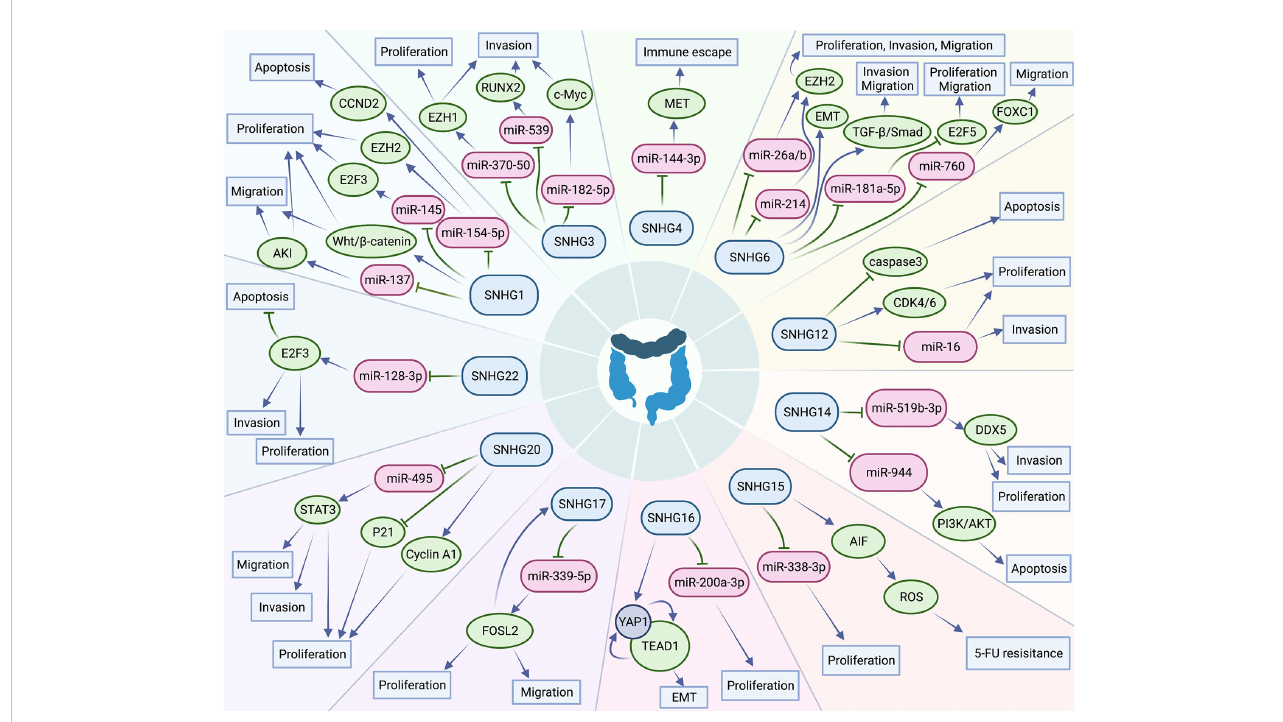
FIGURE 11 Small nucleolar RNA host genes involved in a series of cellular biological roles in colorectal